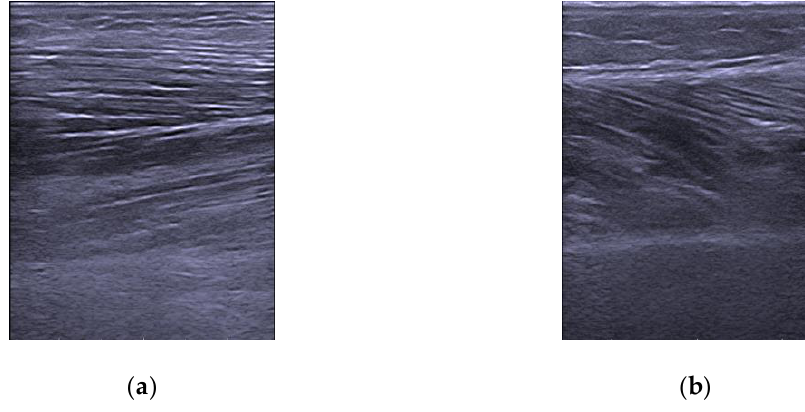
Figure 1. ( a ) Tibialis Anterior transverse ultrasound image, ( b ) Medial Gastrocnemius transverse ultrasound image.